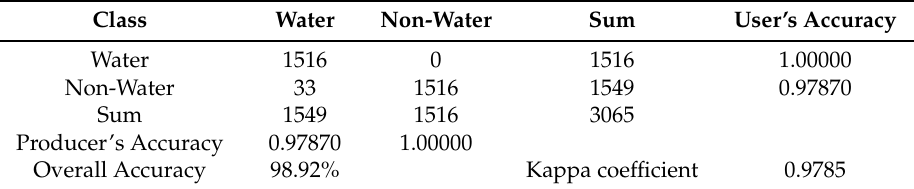
Table 6. Validation statistics of NDWI for water body identification.